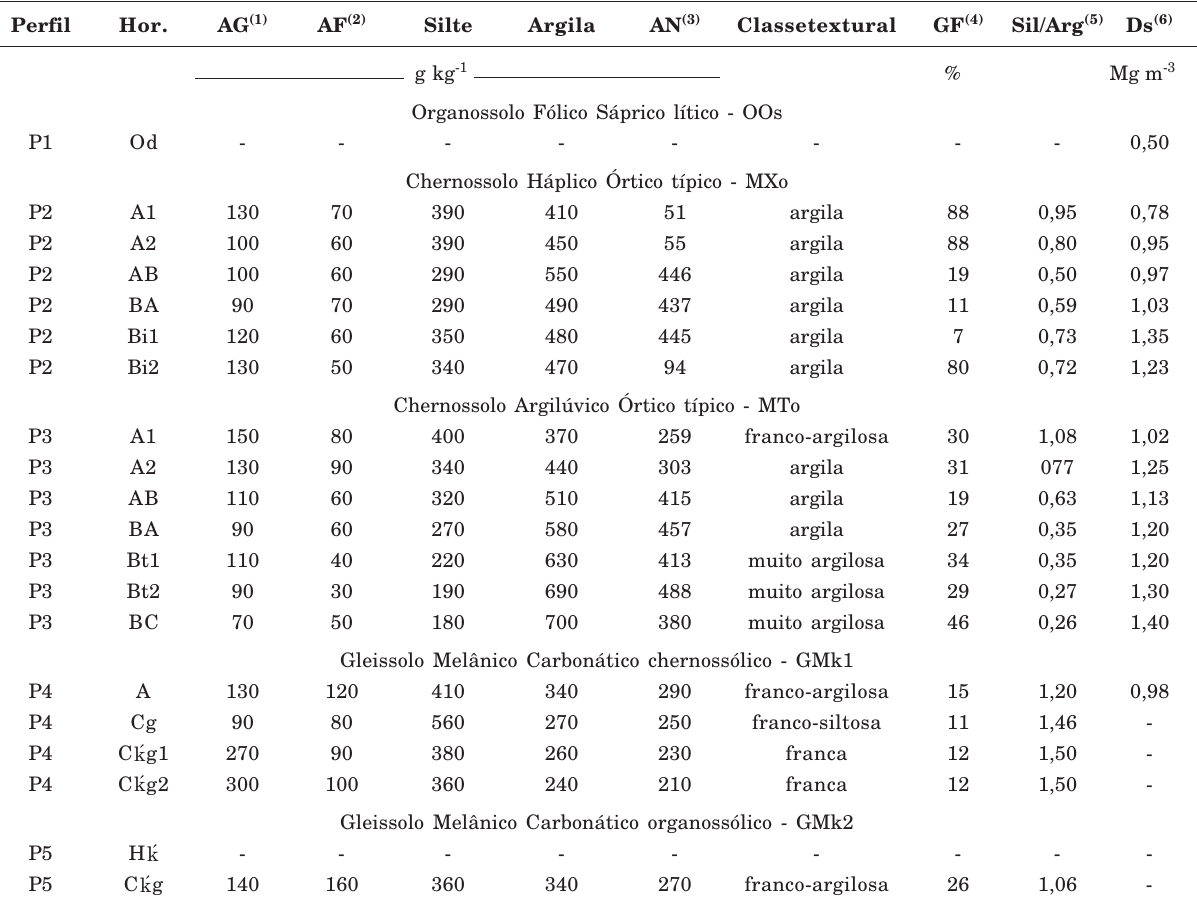
Hor. = horizonte; (1) AG = areia grossa; (2) AF = areia fina; (3) AN = argila natural; (4) GF = grau de floculação; (5) Sil/Arg = relação silte/argila; (6) Ds = densidade do